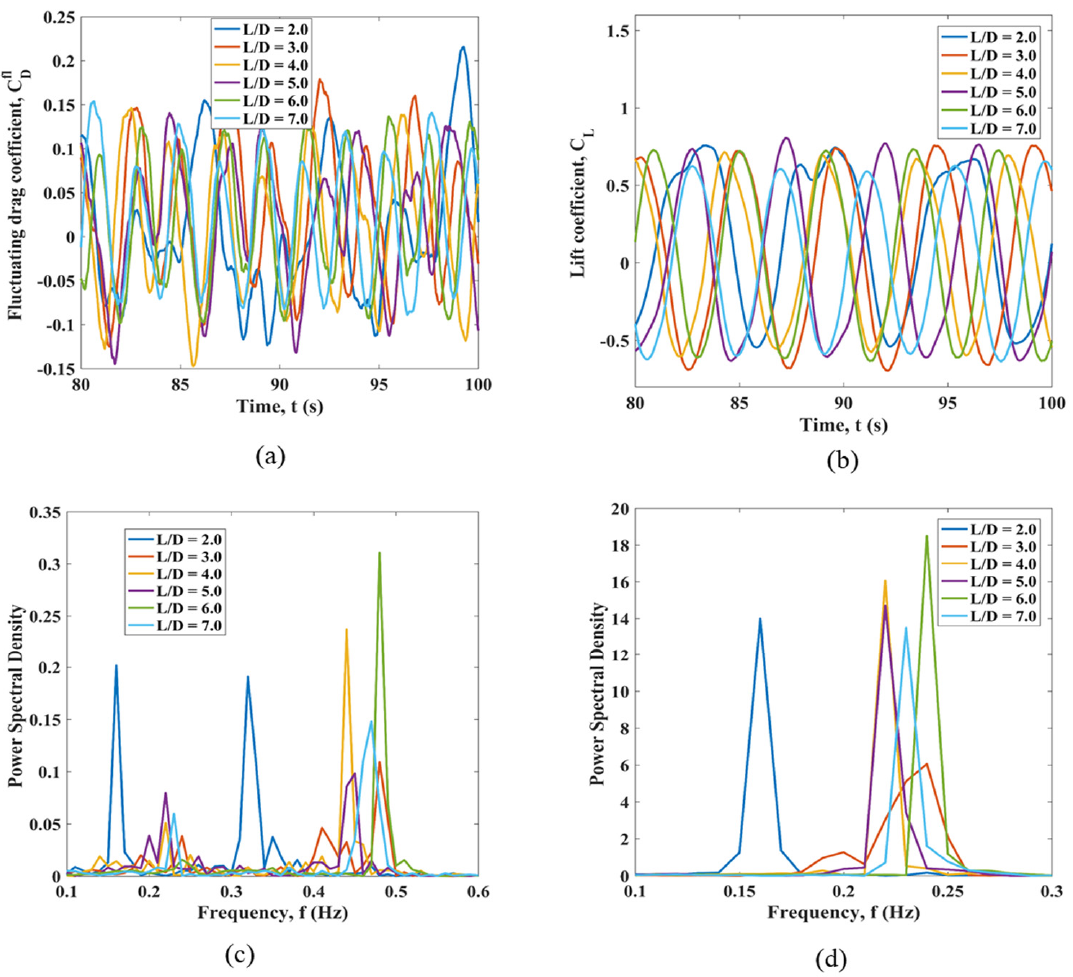
Figure 3. Fluid force coefficients for cylinder 1 immersed in planar sheared flow: ( a ) time history of the fluctuating drag coefficient; ( b ) time history of the lift coefficient; ( c ) the fluctuating drag coeffi–cient FFT; ( d ) the lift coefficient FFT.